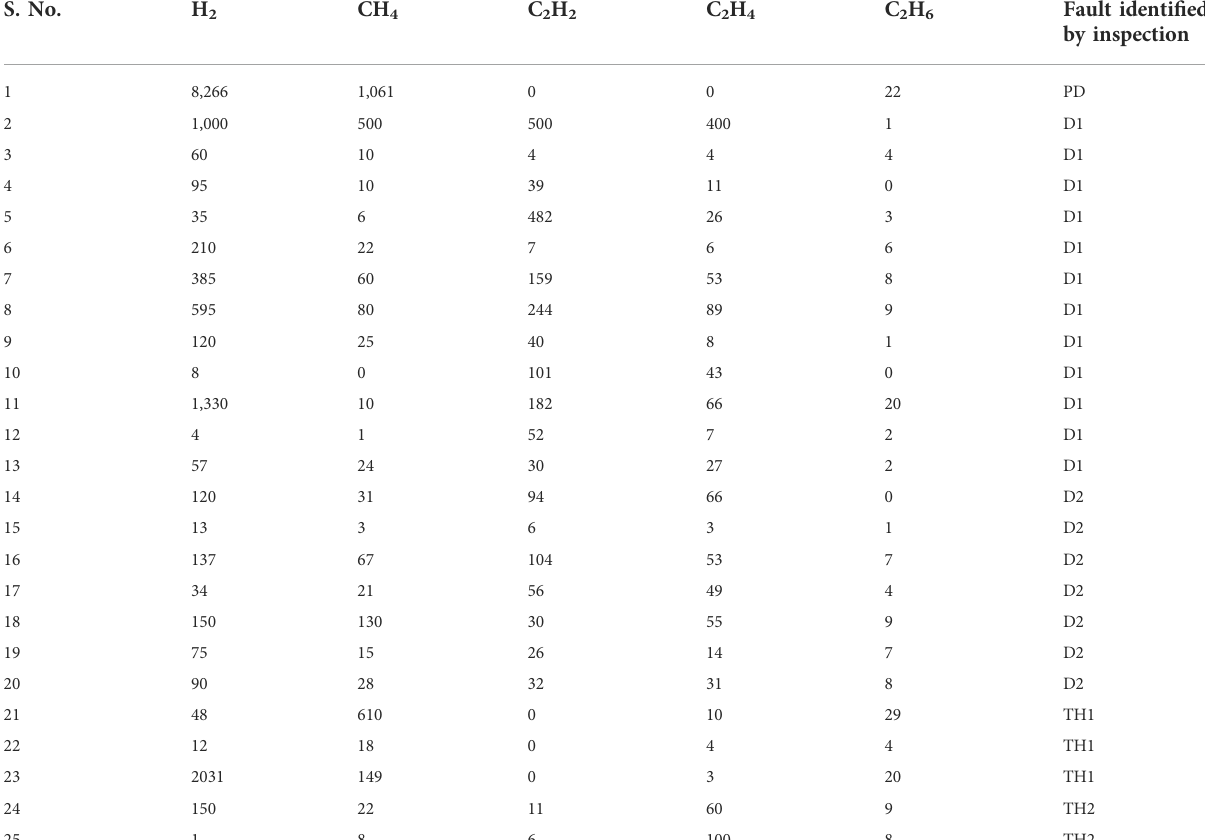
TABLE 3 Transformer fault cases for diagnostic testing of E-Nose model. S.